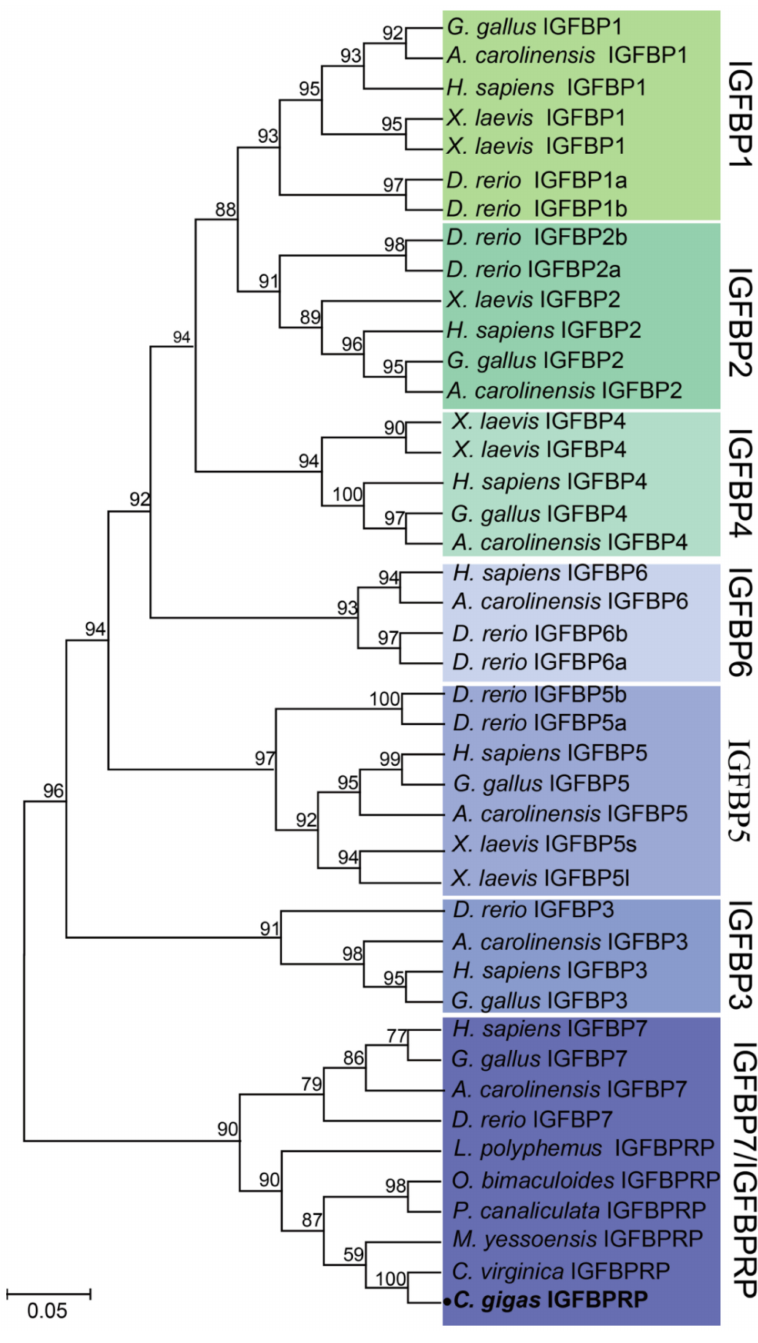
Figure 3. Phylogenetic analyses of the IGFBP superfamily. The amino acid sequences of the insulin- like growth factor-binding proteins from Homo sapiens , Gallus gallus , Xenopus laevis , Anolis carolinensis , Danio rerio , Limulus polyphemus , Mizuhopecten yessoensis , Octopus bimaculoid , Pomacea canaliculata , Crassostrea virginica, and Crassostrea gigas were retrieved from the NCBI database. The phylogenetic tree was constructed using the neighbor-joining (NJ) approach in MEGA7. The reliability of the topological structure was tested using 1000 bootstrap